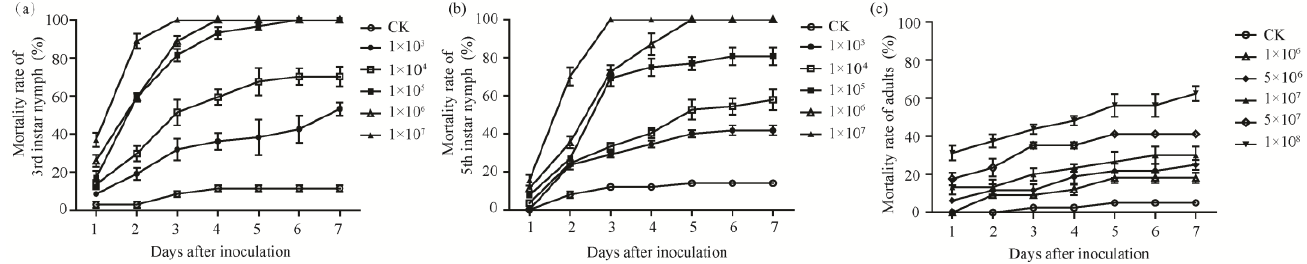
Figure 3. Pathogenicity of C. fumosorosea SCAU-CFDC01 against D. citri. ( a – c ) Trend over time in the percentage mortality of 3rd and 5th instar nymphs and adults of D. citri with days after inoculation with six concentrations of C. fumosorosea . CK (control check): distilled